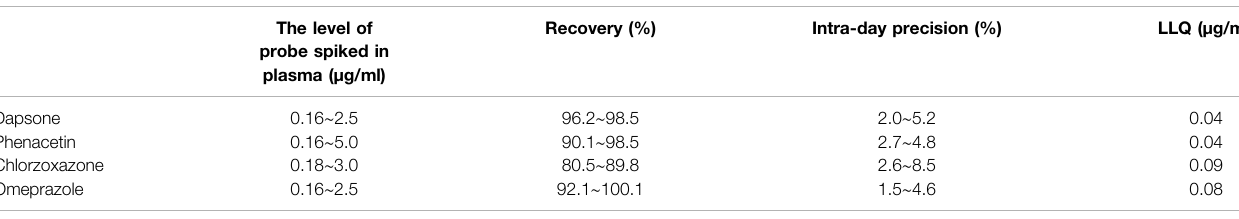
TABLE 3 | Recovery, intra-day precision, and LLQ of the HPLC method.